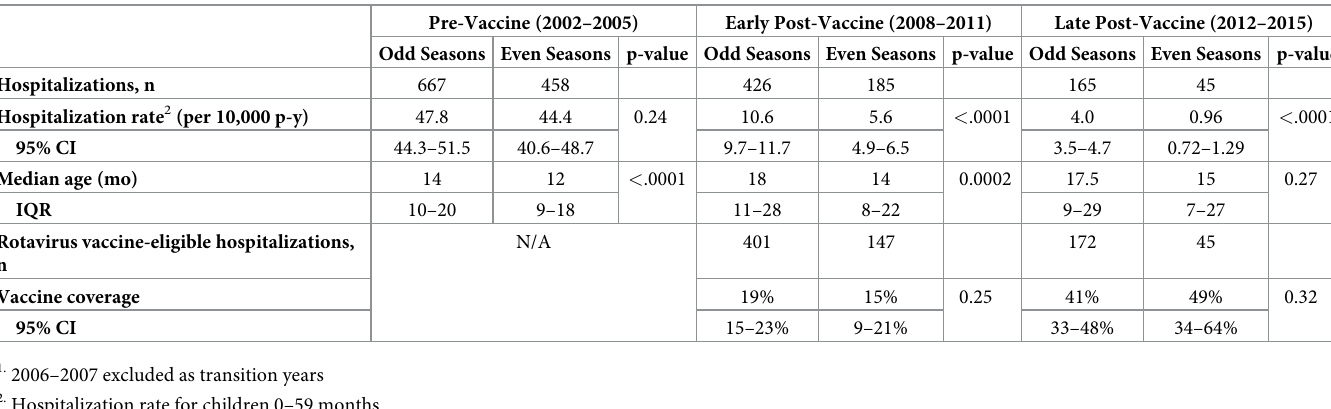
Table 1. Age and vaccination coverage for children < 60 months admitted for rotavirus during rotavirus seasons (Jan-Jun) before and after vaccine introduction 1 .